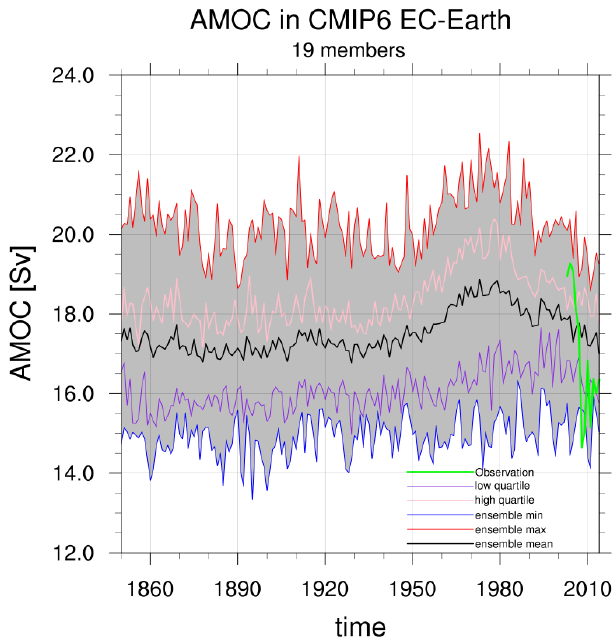
Figure 16. Time series of maximum AMOC (maximum between 24.5–27.5 ◦ N) for ensemble mean (black), low quartile (purple), high quartile (pink), ensemble minimum (blue), and ensemble max- imum (red) are shown for 19 members of EC-Earth3. Observation data are shown with green from RAPID-MOCHA array observa- tions (Smeed et al., 2017).